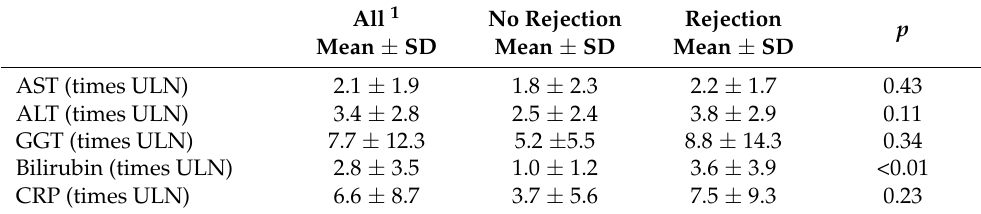
Table 2. Biochemistry at time of biopsy.